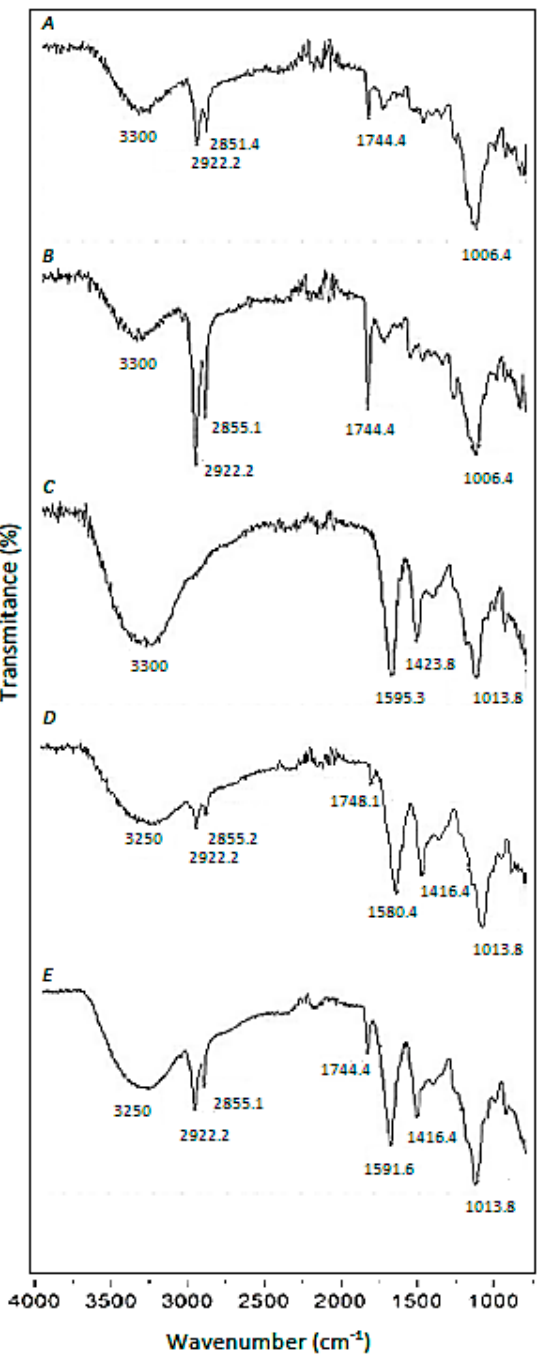
Figure 1. FTIR spectra. ( A ): Raw Spent-Coffee-Grounds (SCGs), ( B ): Pre-treated SCGs, ( C ): Calcium Alginate (CA) beads, ( D ): Calcium Alginate/Spent-Coffee-Grounds (CA/SCGs) (3:3) beads, ( E ): CA/SCGs (3:10) beads.